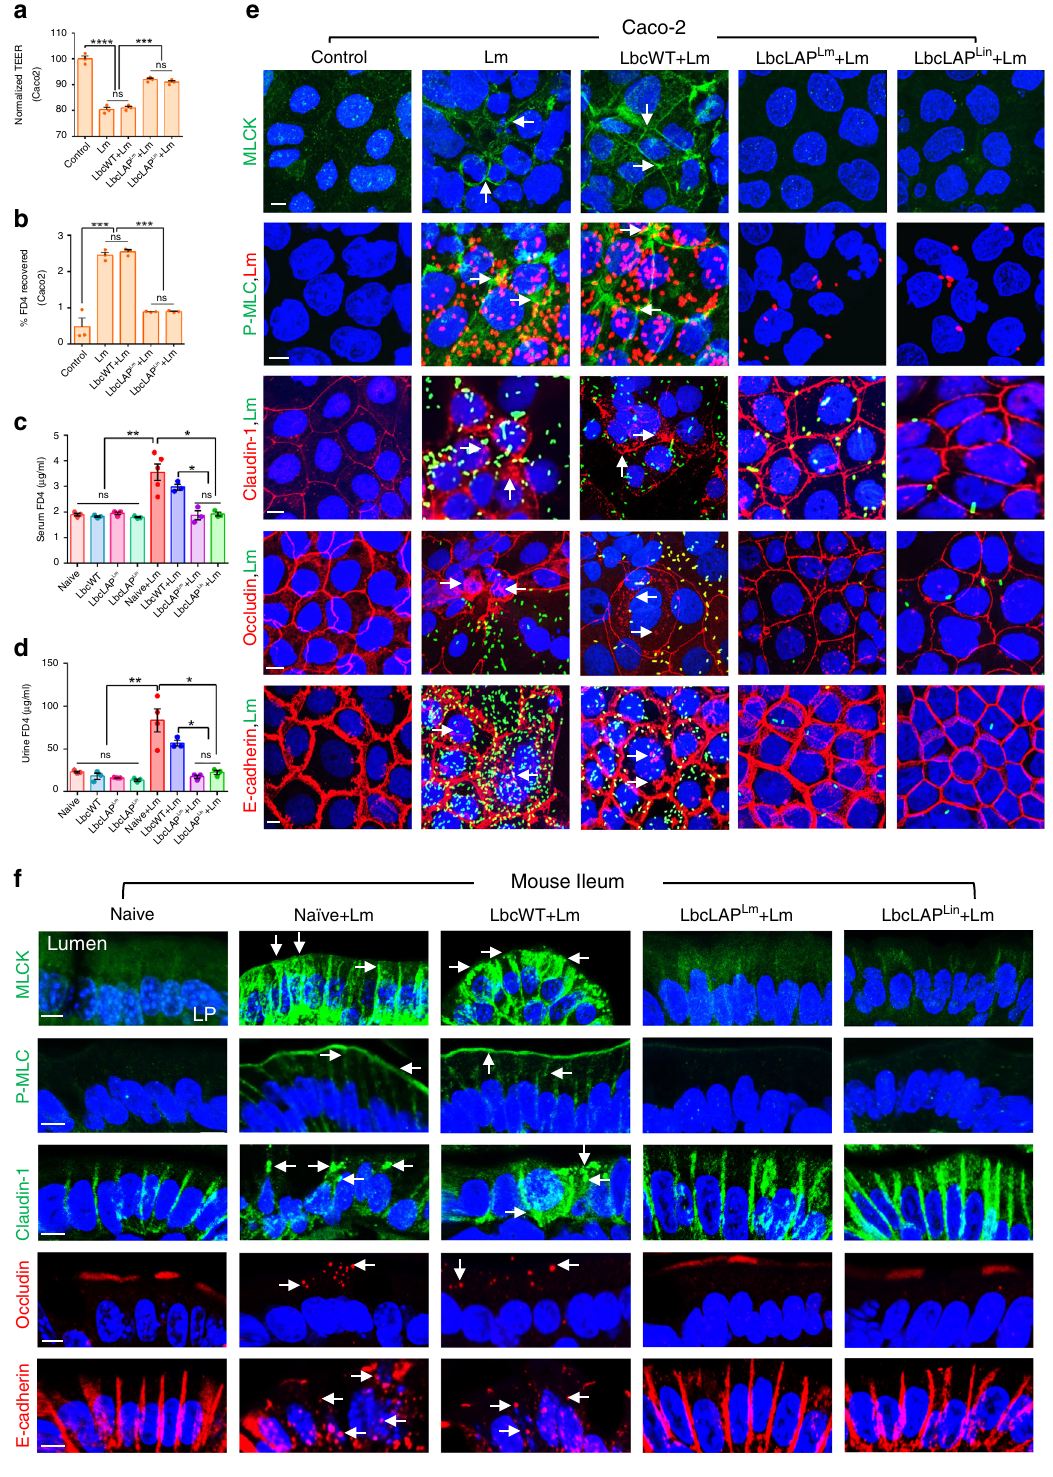
BLP-mediated inhibition of Lm -induced redistribution of TJ and AJ pools and maintenance of the cell junctional architecture of claudin-1, occludin, and E-cadherin. Our data further imply that the intimate association of BLP strains despite Lm infection prevents Lm from gaining the physical proximity required for activation of the downstream signaling pathways to breach the epithelial barrier. The preservation of MUC2 + GC ’ s and barrier functions by the BLP strains may be a consequential response